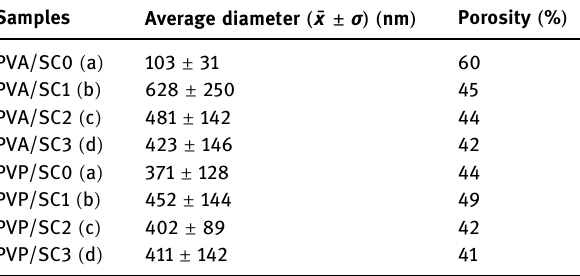
Table 2: Average fi ber diameter and percentage porosity ratio of PVA/SC and PVP/SC fi brous sca ff olds